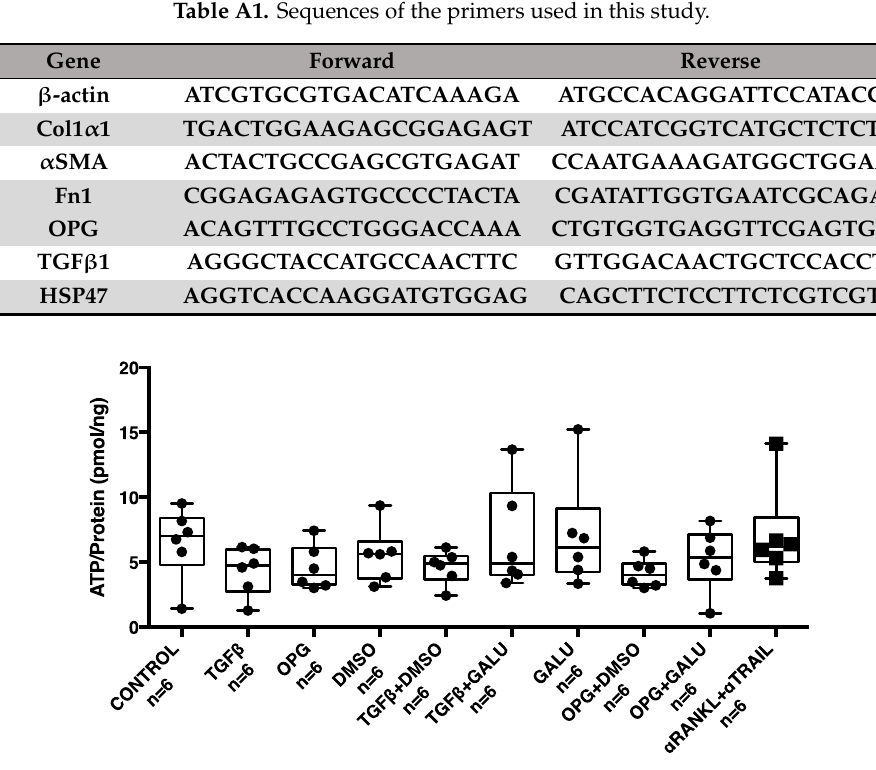
Figure A1. Treatments did not compromise viability of mouse liver slices. The treatments used in these studies did not significantly compromise the viability of the mouse liver slices (n = 6, Kruskal-Wallis test corrected for multiple testing).